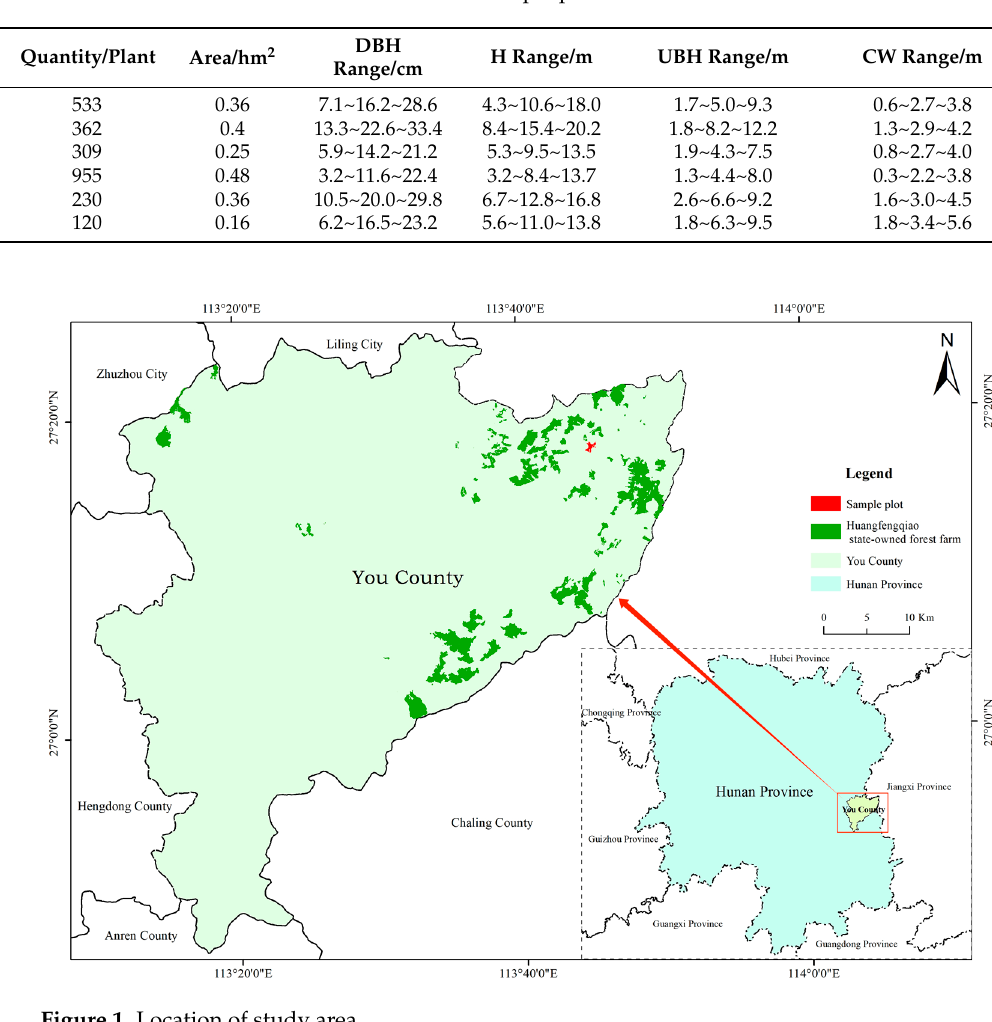
Table 1. Statistical table of tree factors in the sample plot.